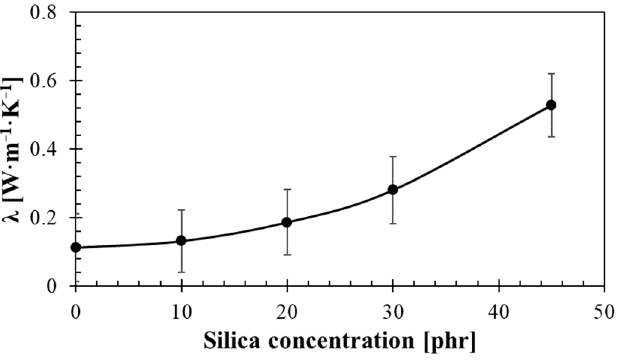
Figure 10. Effect of silica concentration on thermal conductivity of the tested rubber composites.